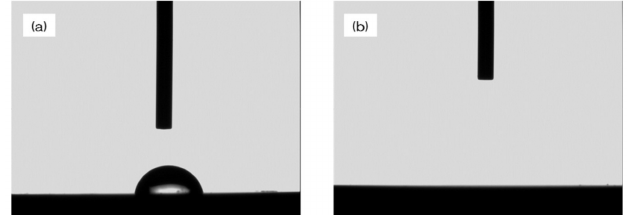
Figure 3. The contact angle between the surface of the NANOZR treated with UV and the surface of the untreated NANOZR is shown. The UV-treated NANOZR surface was superhydrophilic. ( a —test; b